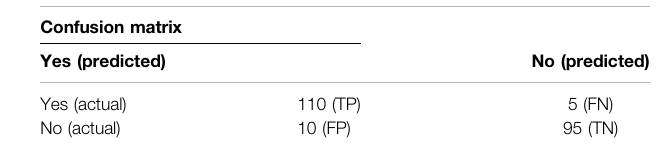
TABLE 3 | Confusion matrix for